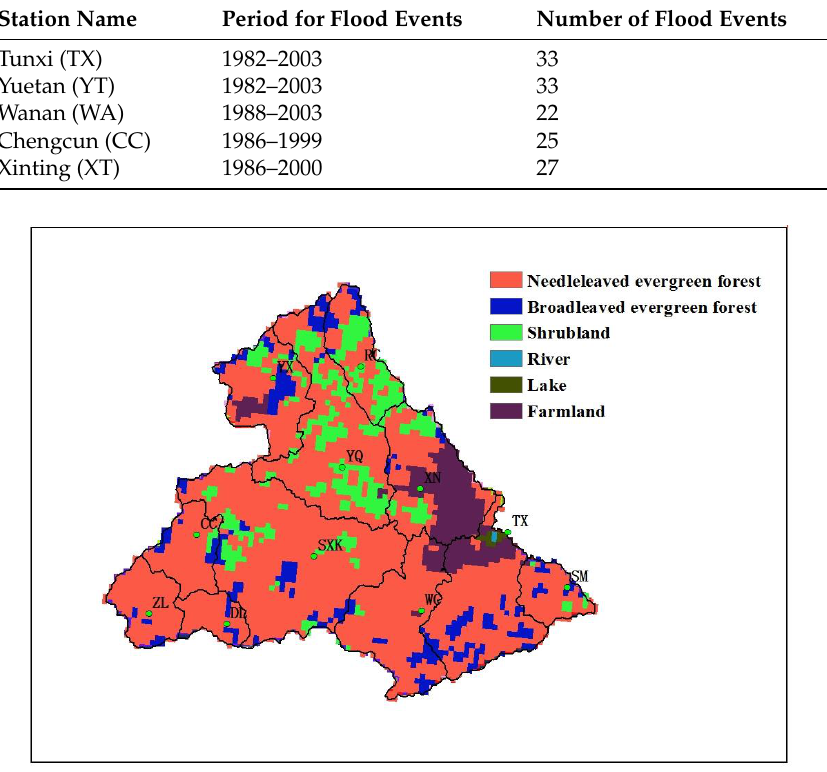
Figure 4. Land cover type maps for Tunxi